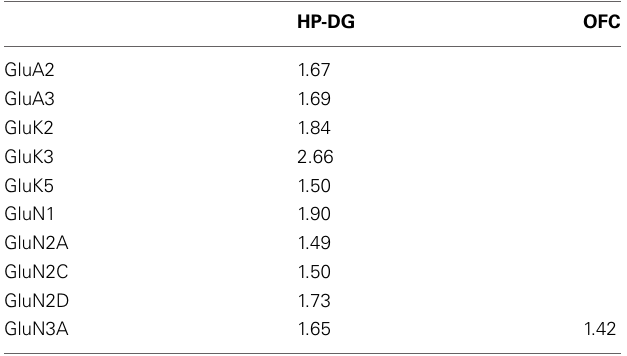
Table 1 | Fold increase in expression of ionotropic glutamate receptor subunits in alcoholics compared to non-alcoholic